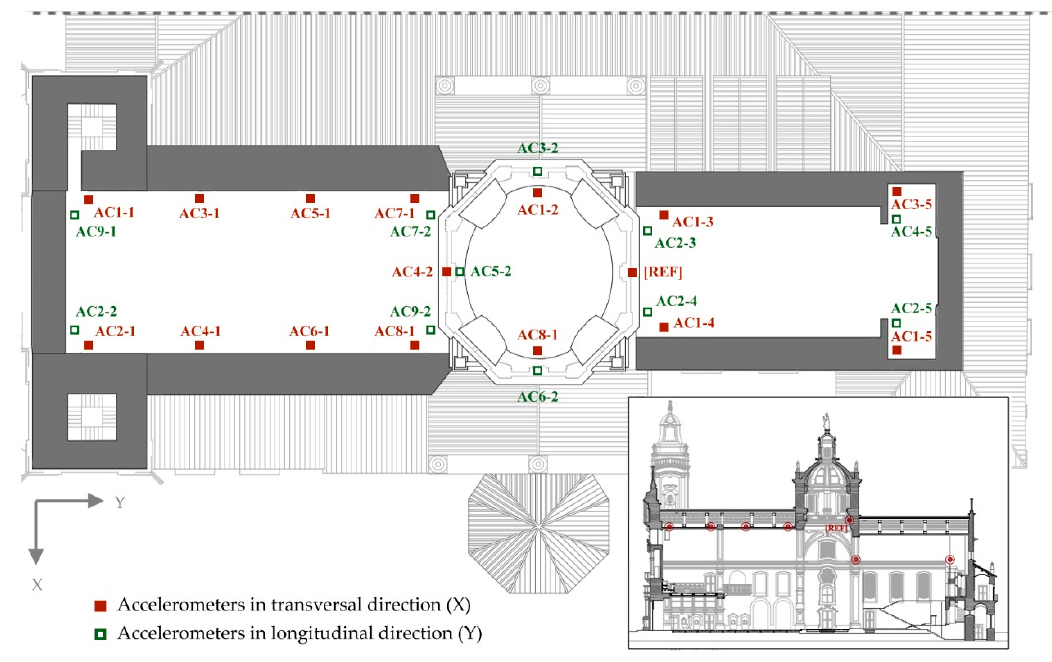
Figure 3. Location of the accelerometers for the dynamic identification tests.